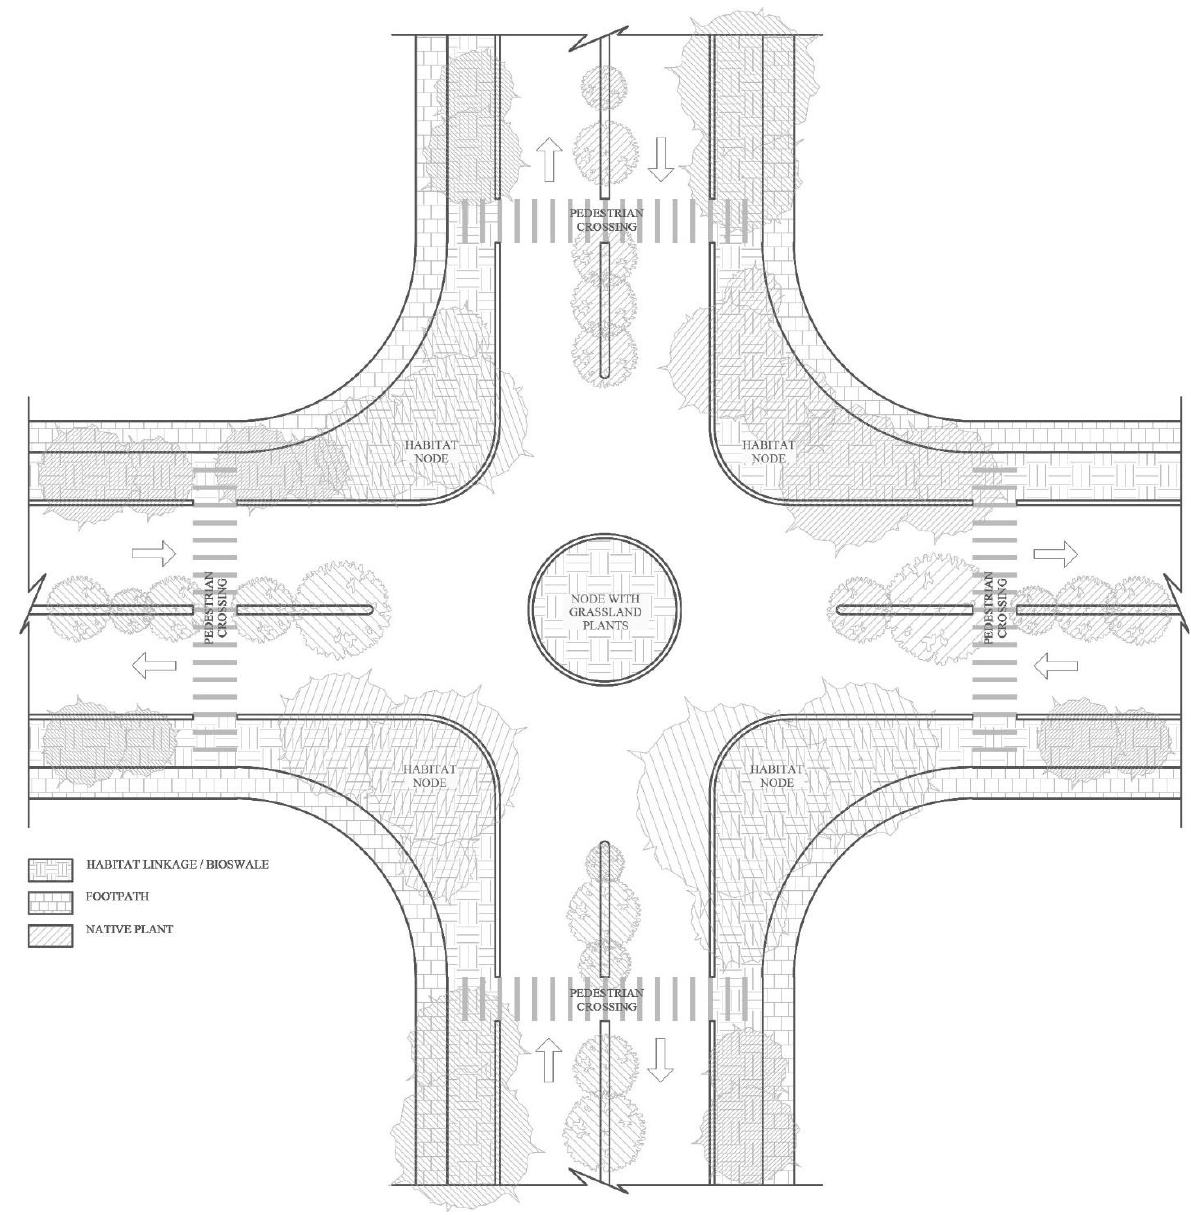
Figure 3: Proposed road intersection plan showing roadside habitat linkages and habitat intermediate nodes.